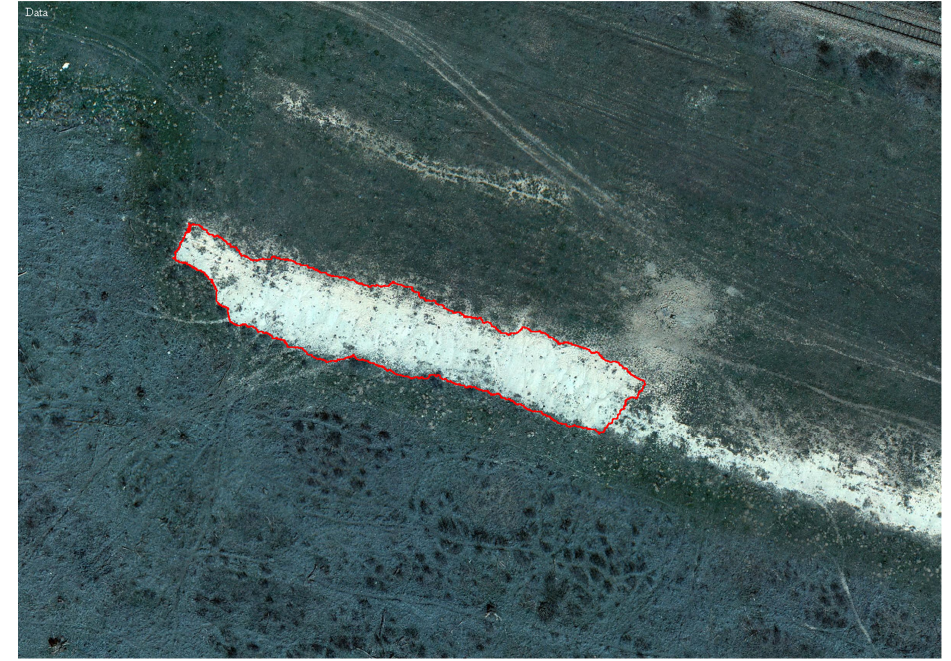
Figure 4. Semi-automatic segmentation of a part of the halophytic vegetation area on UAV data.